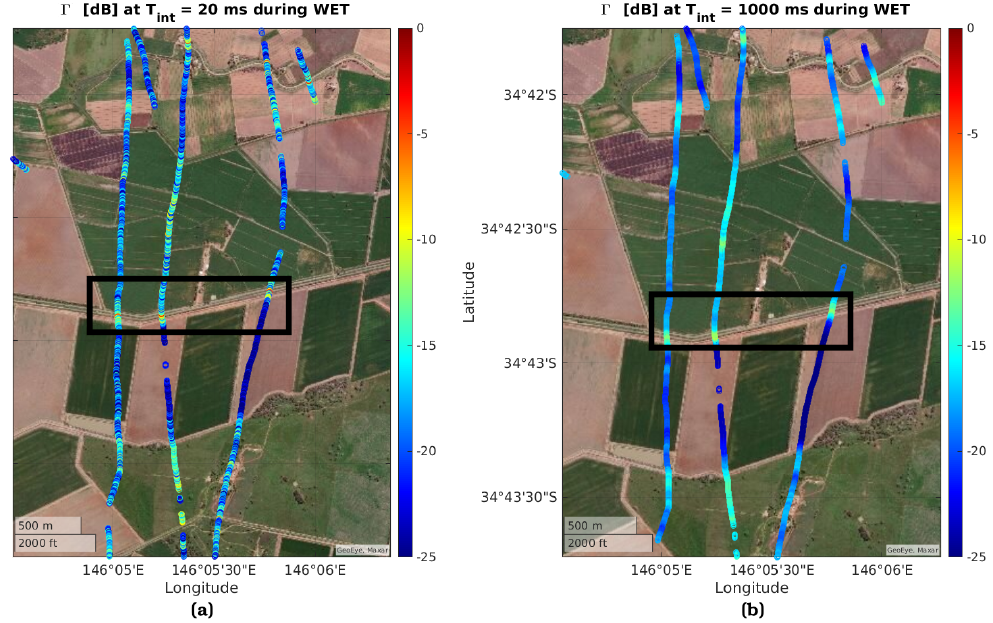
Figure 9. Geolocated MIR reflectivities in Yanco site A during Wet flight at different T int : ( a ) 20 ms and ( b ) 1000